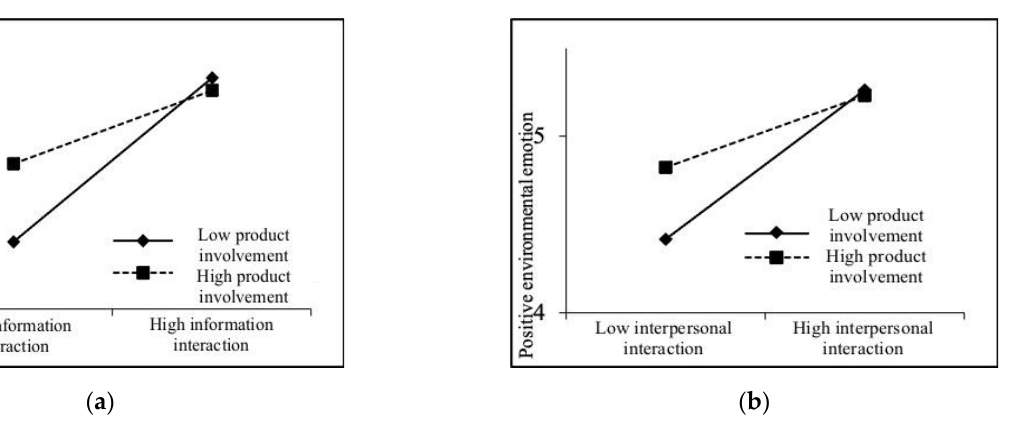
Figure 2. Moderating effect of product involvement. ( a ) Moderating effect of product involvement on the path “green information interaction—positive environmental emotion”. ( b ) Moderating effect of product involvement on the path “green interpersonal interaction—positive environmental emotion”.